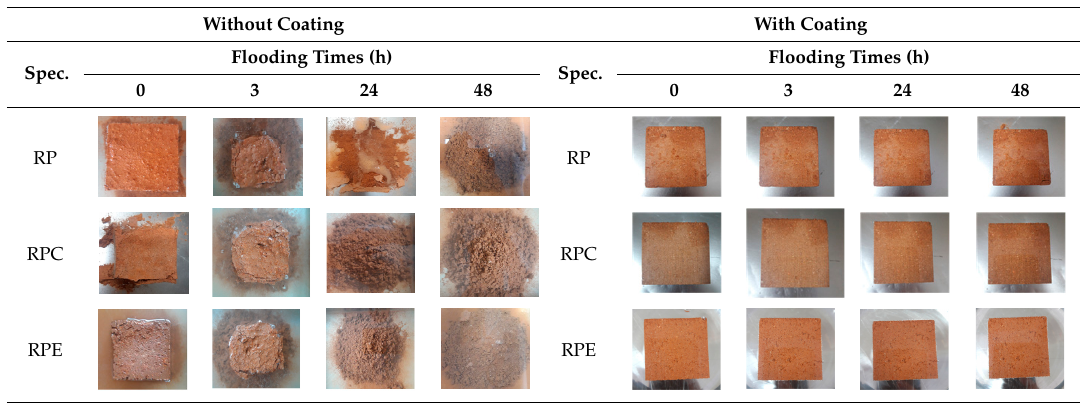
Table 5. Water Loosening Results for Red Clay Binder Specimens.